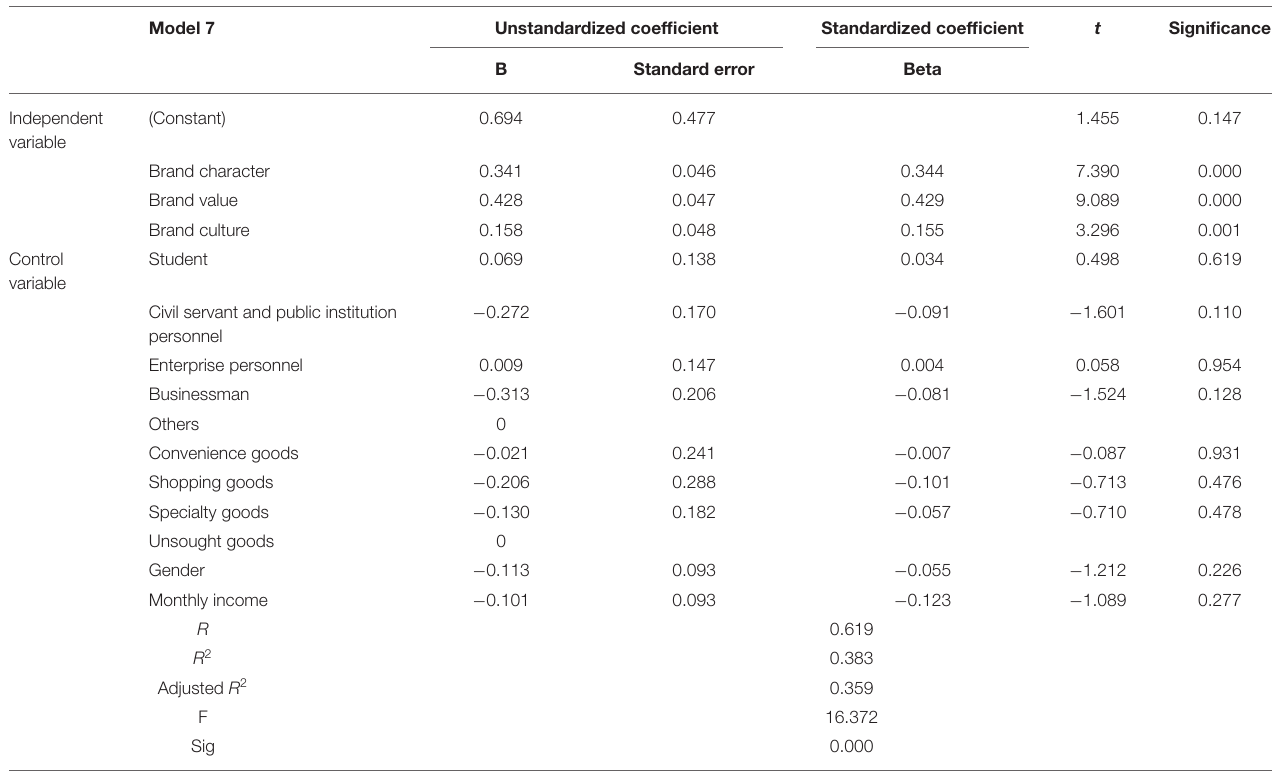
TABLE 8 | Regression analysis of each dimension of brand elements to service